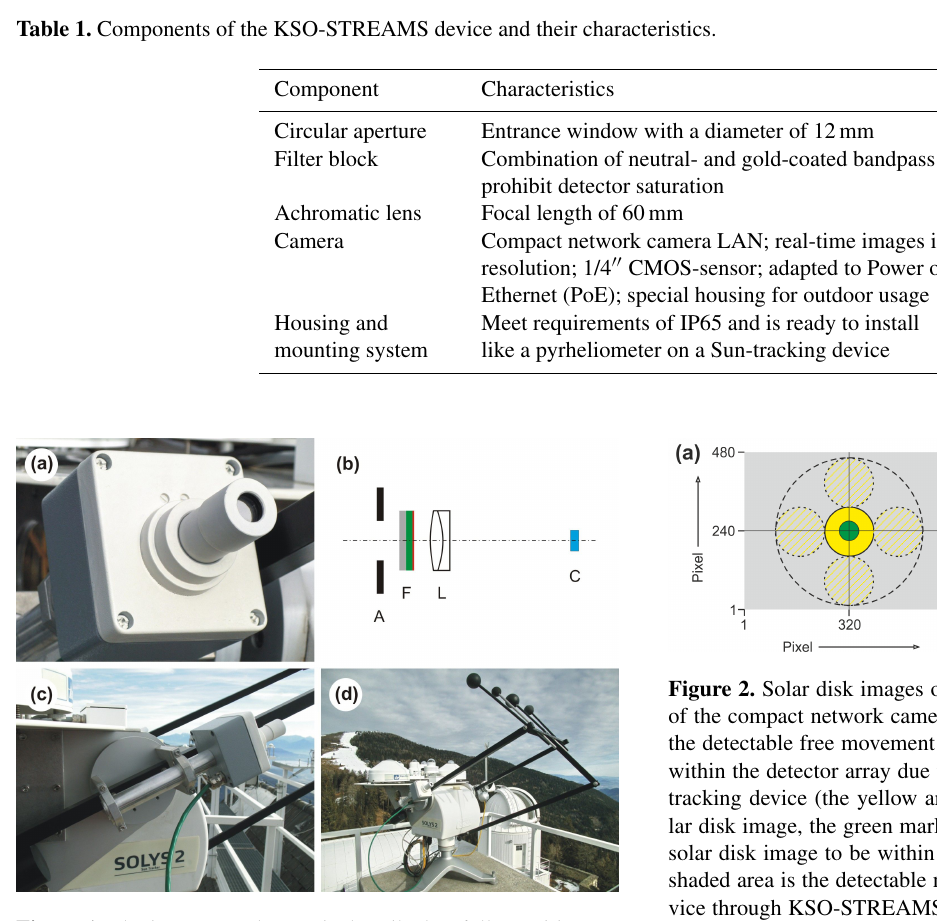
Figure 1. The instrumental setup is described as follows: (a) oper- ating device; (b) optical layout with the following labeled compo- nents: circular aperture (A), filter block (F), achromatic lens (L), and camera chip (C); (c) mounting system; (d) radiation platform with KSO-STREAMS mounted on the Sun-tracking device (SOLYS2, Kipp & Zonen) at the Kanzelhöhe Observatory ARAD site.